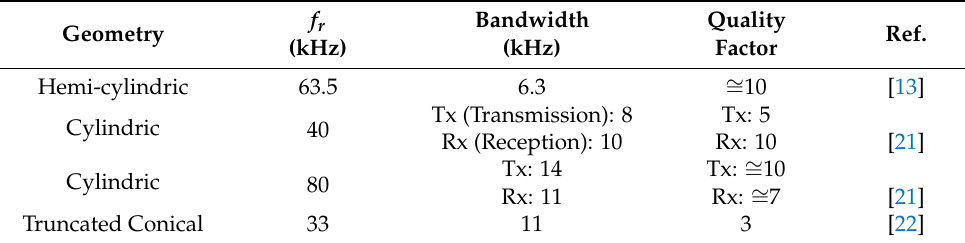
Table 1. Characteristics of representative PVDF ultrasonic sensors for in air applications.